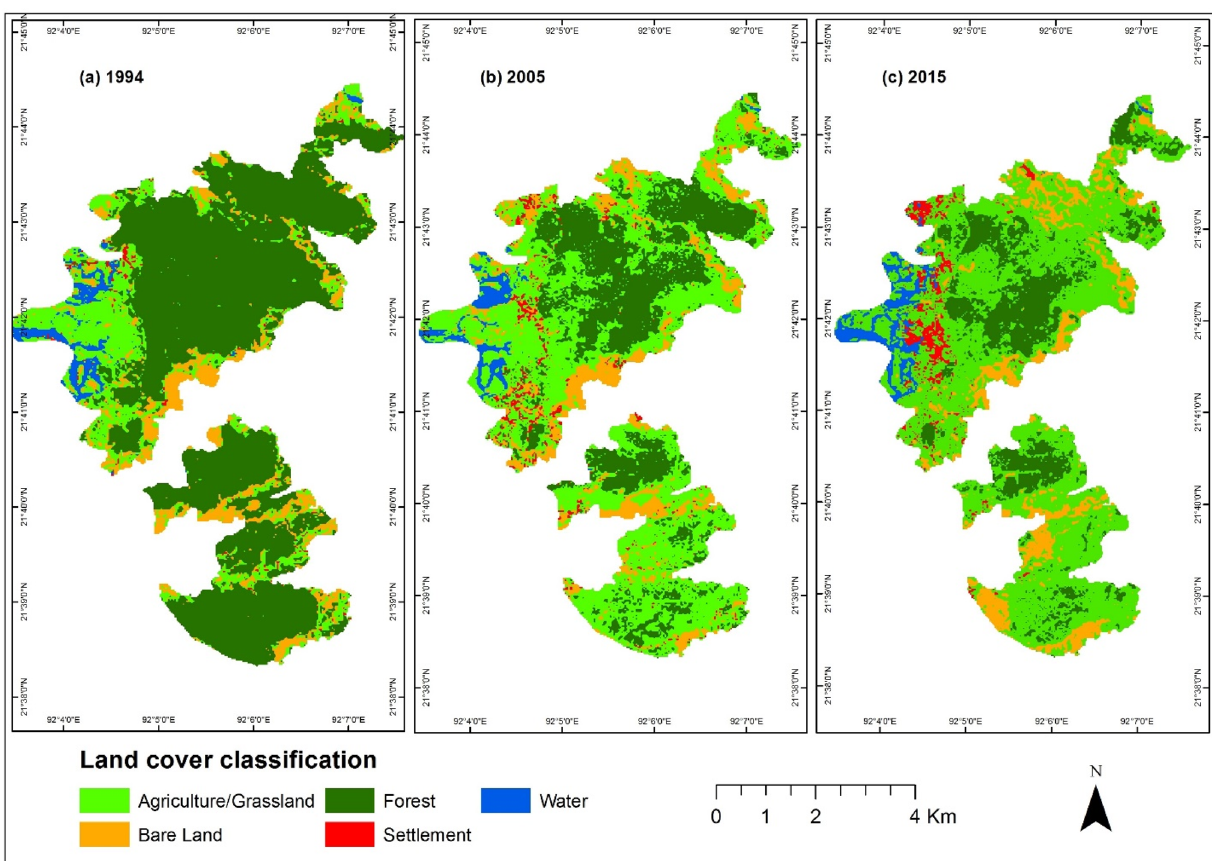
Fig. 2 Land cover classification of Fashiakhali forest reserve